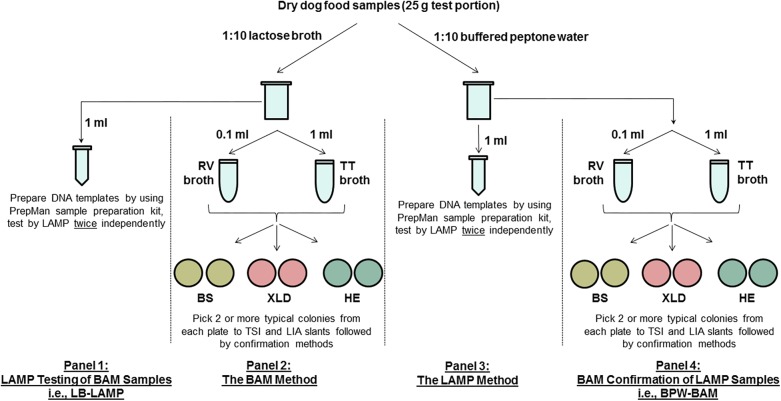
A schematic diagram of the MLV study design comparing the LAMP alternative method and the FDA BAM Chapter 5 reference method for the detection of Salmonella Infantis ATCC 51741 in 25 g dry dog food test portions. RV, Rappaport-Vassiliadis medium; TT, tetrathionate broth; BS, bismuth sulfite agar; XLD, xylose lysine desoxycholate agar; HE, Hektoen enteric agar; TSI, triple sugar iron agar; LIA, lysine iron agar.